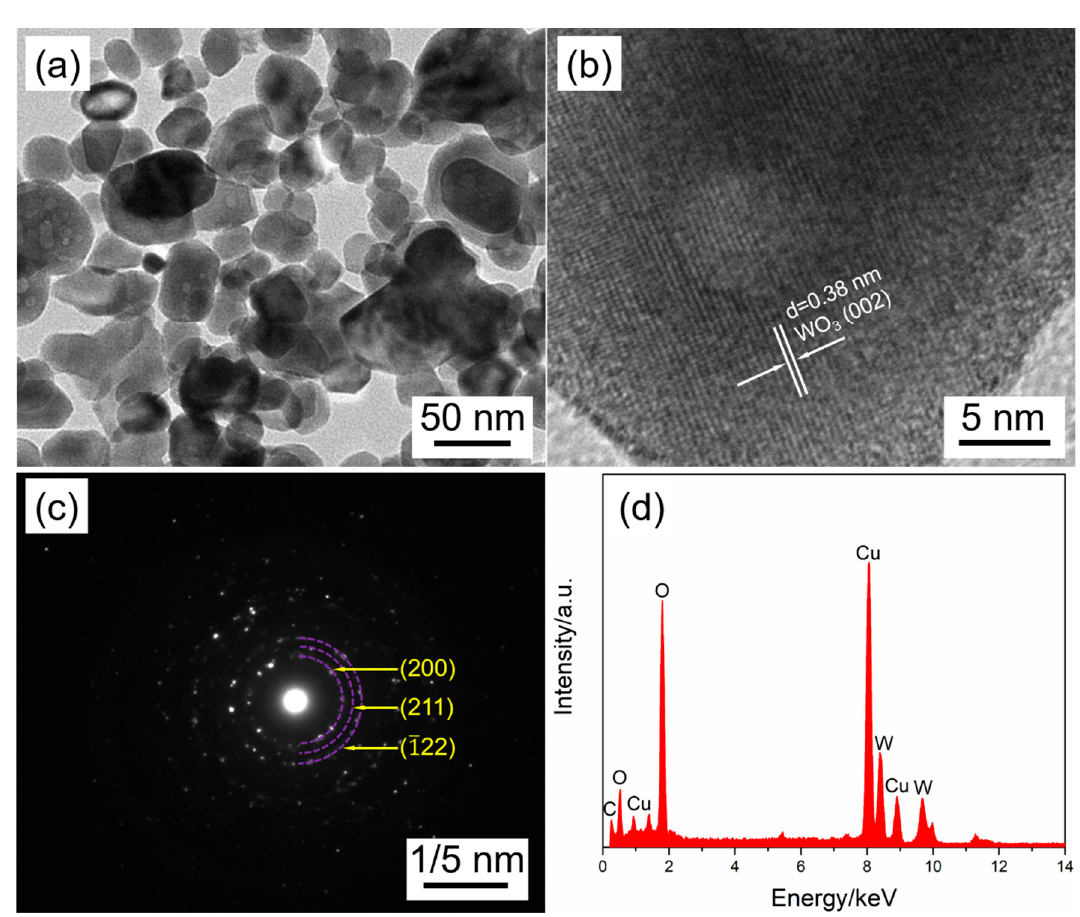
Figure 11. ( a ) Transmission electron microscopy, ( b ) HRTEM, and ( c ) SAED images of the sample S(3, 0.5, 500). ( d ) The corresponding EDX spectrum.